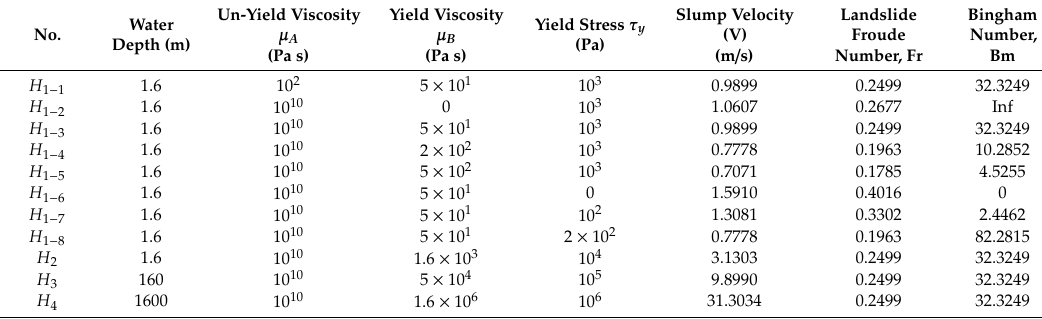
Table 2. Froude number and landslide Bingham numbers in this